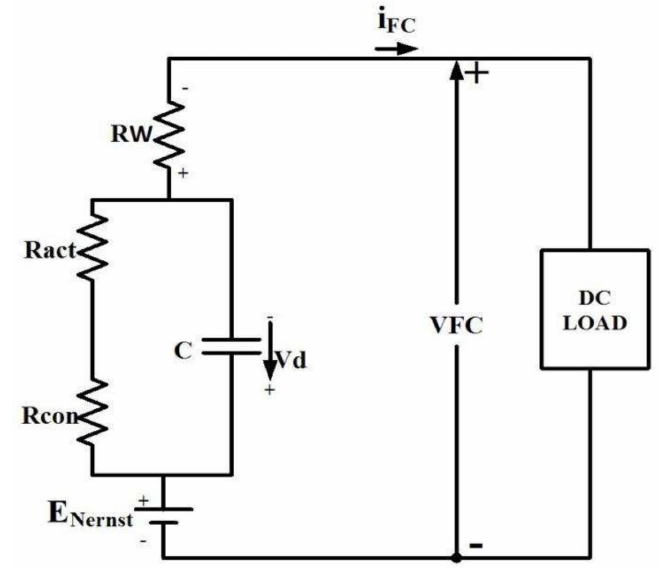
Figure 4. Equivalent circuit of a fuel